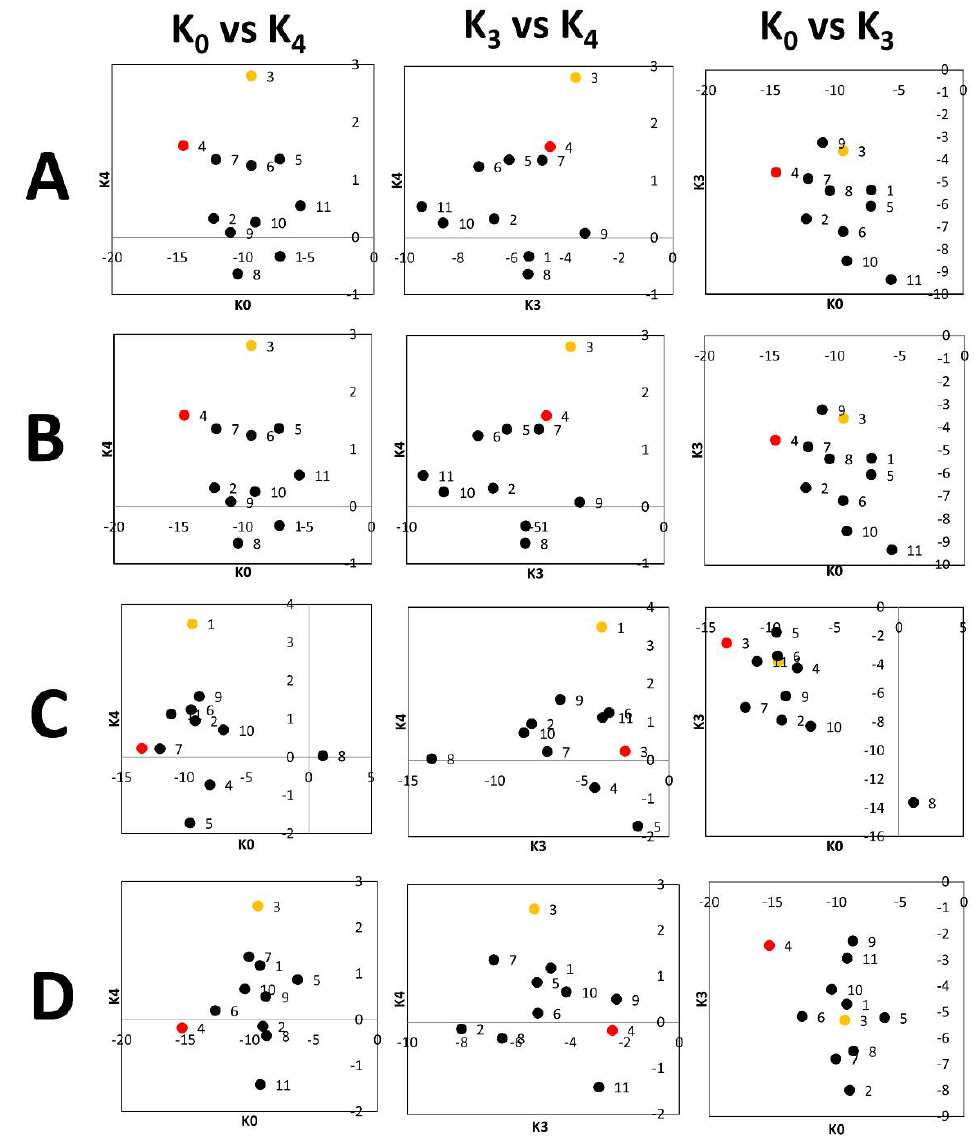
Figure 9. Graphs of the average of each class for the Kennaugh elements used to classify water (red), flooded vegetation (yellow), and other (black). ( A ) 2 April 2016; ( B ) 24 April 2016; ( C ) 5 May 2016; and ( D ) 18 June 2016.